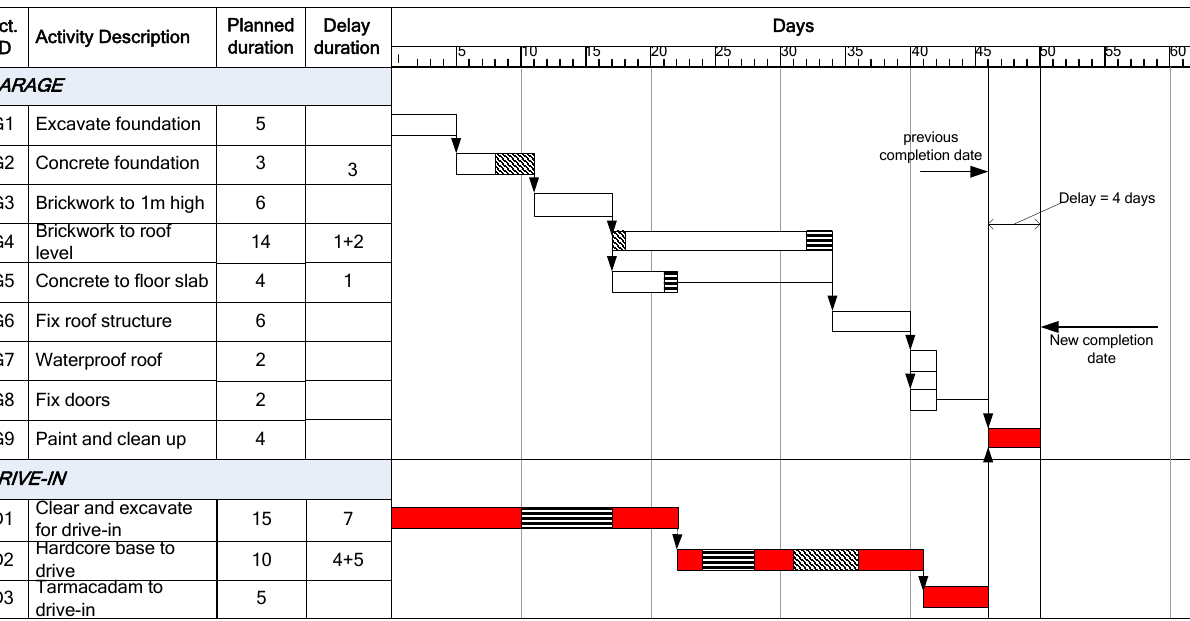
Figure 11. Impact of seventh delay.